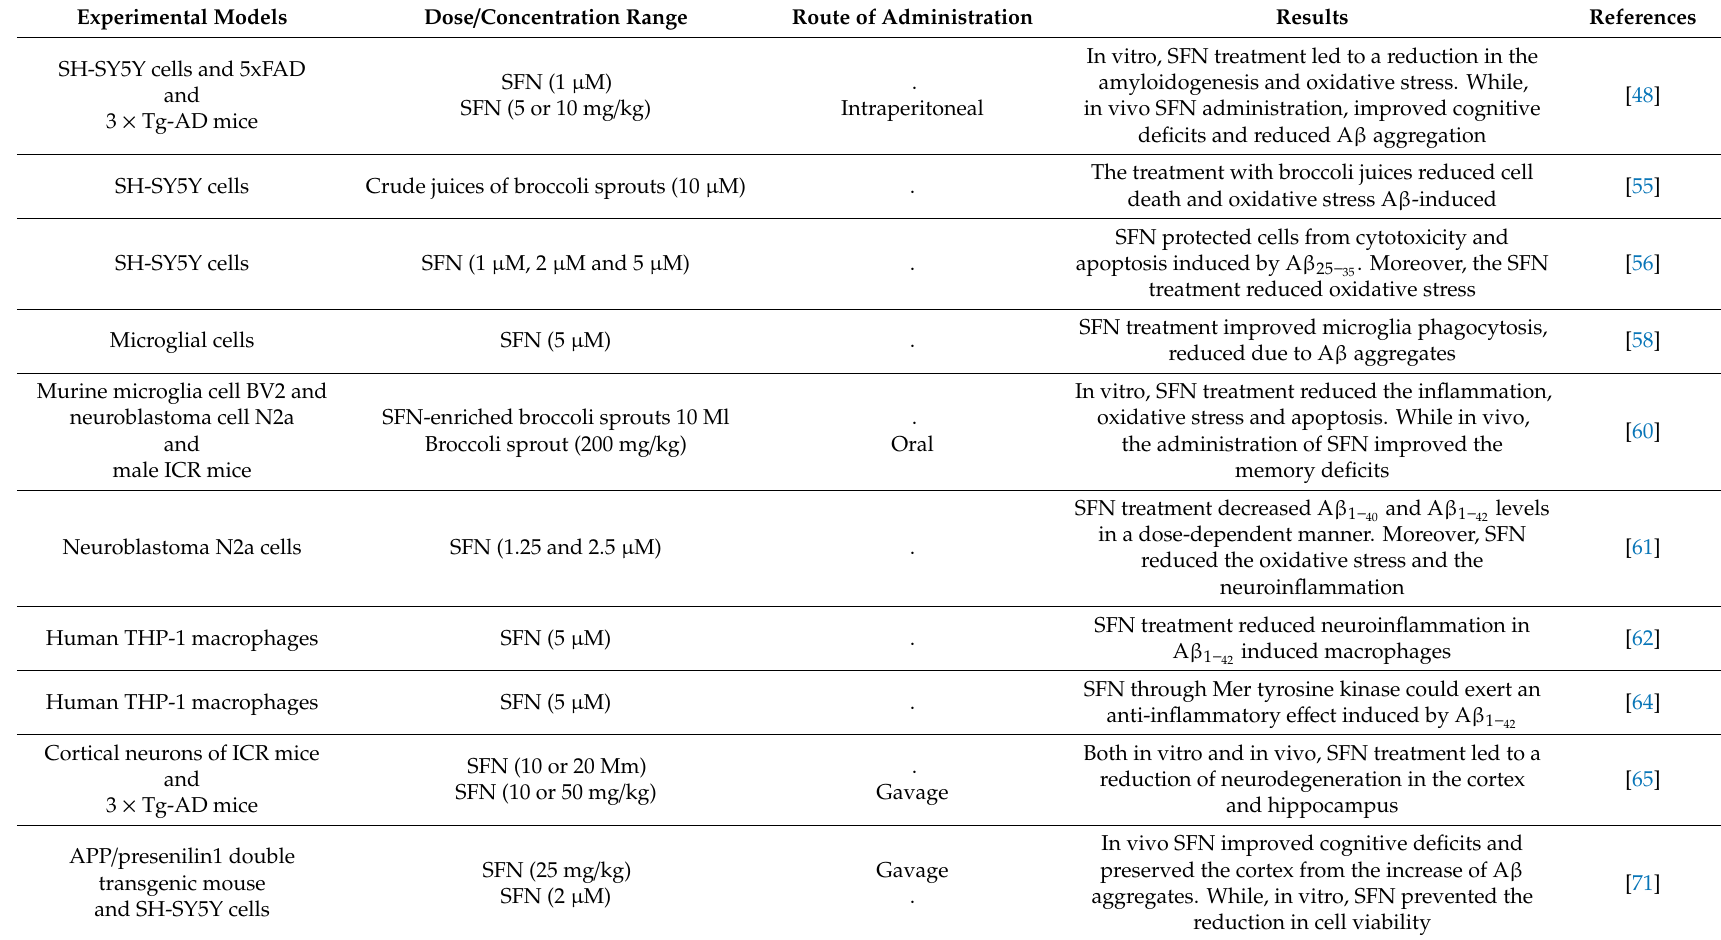
Table 2. This table shows the in vitro studies that reported the e ff ects of SFN in the treatment of AD. Specifically, the table describes the models used in the experimental studies, the type of treatment, the dosage, and the results